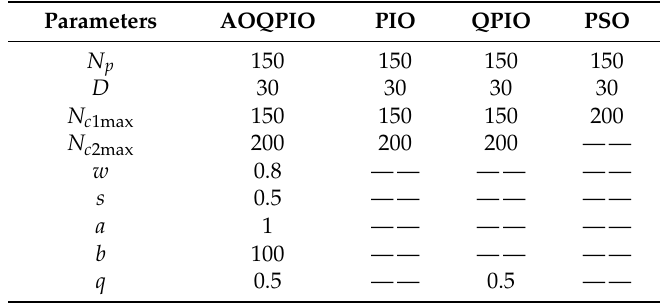
Table 1. The parameters used in experiments of different algorithms.